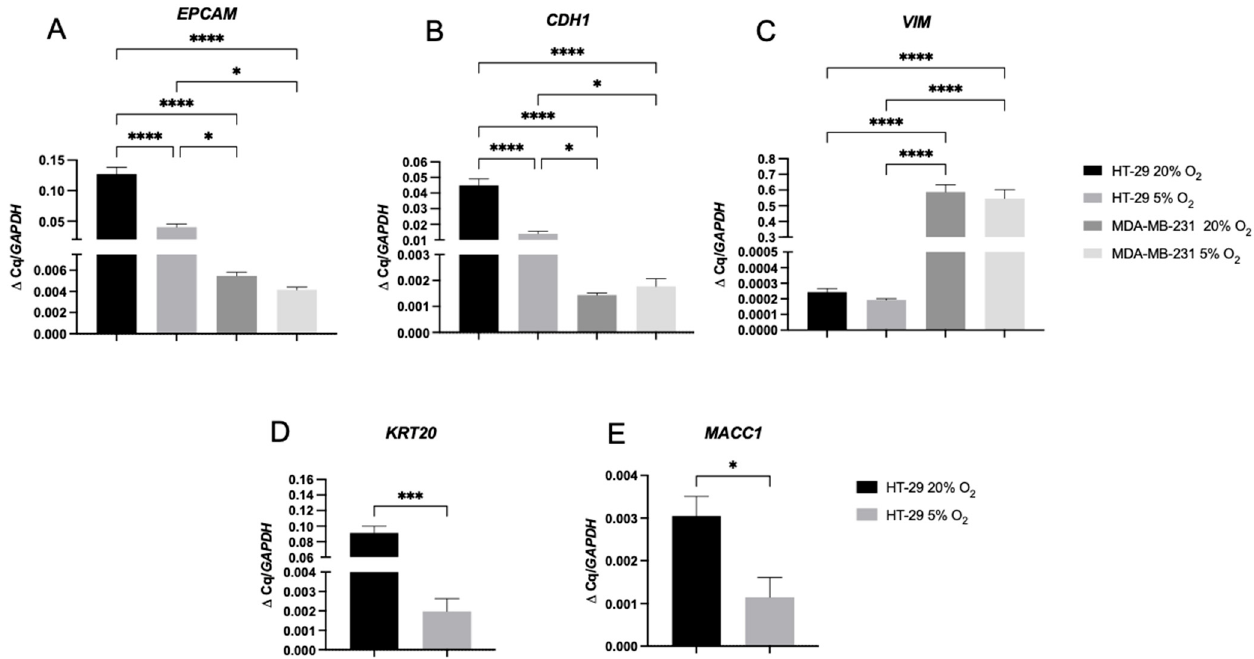
Figure 4. EMT gene marker expression within HT-29 and MDA-MB-231 2D monolayers cultured for 7 days in either normoxia (21% O 2 ) or physiological hypoxia (5% O 2 ). mRNA expression of ( A ) Epithelial cell adhesion marker ( EPCAM ), ( B ) E-cadherin ( CDH1 ), ( C ) Vimentin ( VIM ), ( D ) Cytokeratin 20 ( KRT20 ), and ( E ) Metastasis-associated in colon cancer protein 1 ( MACC1 ). The fold change shown is normalized relative to reference gene glyceraldehyde-3-phosphate dehydrogenase ( GAPDH ). One-way ANOVA significance with Dunnet’s post hoc correction is shown for VIM, EPCAM , and CDH1 with DOF = 11 for all and F-value = 79.5, 95.3, and 82.6, respectively. Unpaired t -test significance is shown for KRT20 and MACC1 with DOF = 4 for both and t-value= 4.413 and 2.917, respectively. All p -value significance is indicated as: * p < 0.05, *** p < 0.0005, **** p < 0.00005.